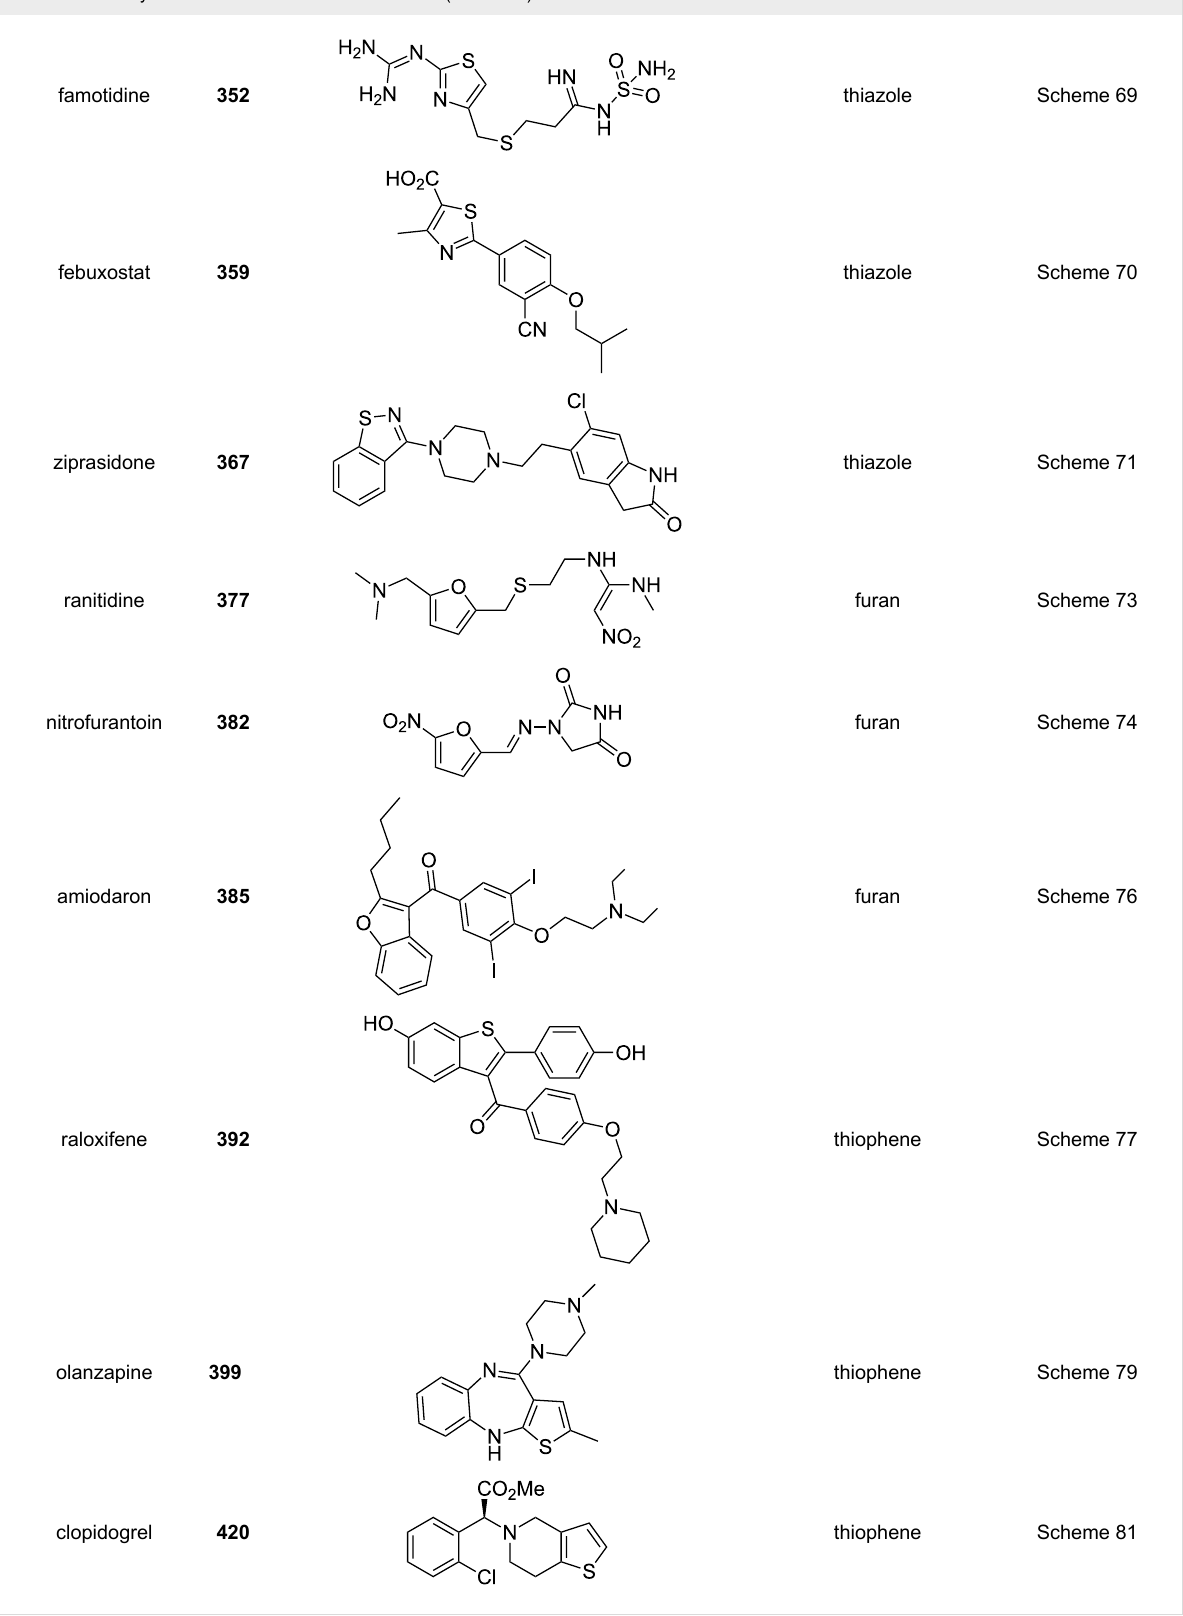
Table 1: Heterocylic structures discussed in this review.